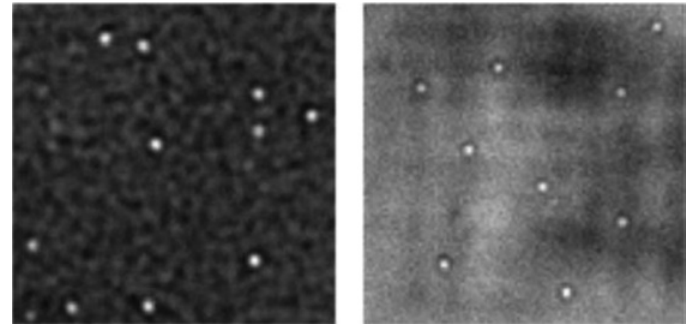
Figure 6: An example readout from an interference reflectance imaging sensor (SP-IRIS) when the substrate is dry (left, 0.8 NA) or when the substrate is mounted in a microfluidic chamber and immersed in water (right, 0.9 NA). Individual vesicular stomatitis virions are detected as small (about 1–3%) diffraction-limited modulations to a reflected reference field. Small fluctuations in the intensity of the reflected refer- ence field are visible in both images. Displayed regions are about 8 × 8 microns. Adapted from [39] (Reprinted with permission from [39], Copyright 2016 American Chemical Society).